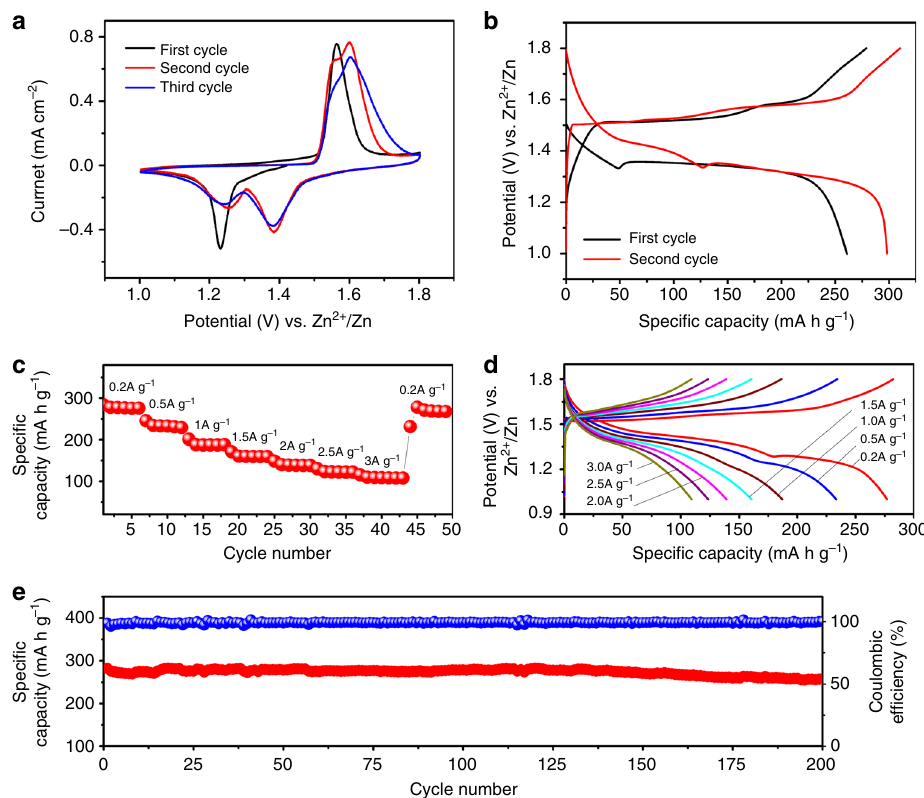
Fig. 2 Electrochemical performance of polyaniline-intercalated MnO 2 nanolayers. a Cyclic voltammetry curves of the coin-type cell (Zn/polyaniline (PANI)- intercalated MnO 2 ) using 2 M ZnSO 4 + 0.1 M MnSO 4 aqueous electrolyte at 0.1 mV s − 1 . b Typical galvanostatic charge/discharge curves at 50 mA g − 1 between 1.0 and 1.8 V of the cell. c , d Rate performance and charge/discharge pro fi les of the cell tested with the charge/discharge current densities varying from 200 to 3000 mA g − 1 . e Cycling performance in terms of speci fi c capacity (red) and the corresponding coulombic ef fi ciency (blue) at a current density of 200 mA g −